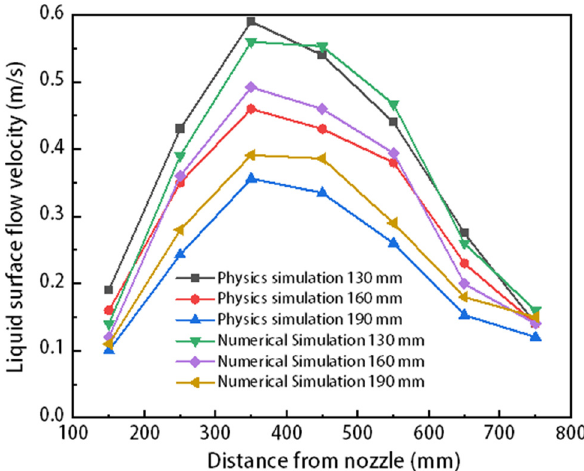
Figure 8: In fl uence of di ff erent submerged depths on surface